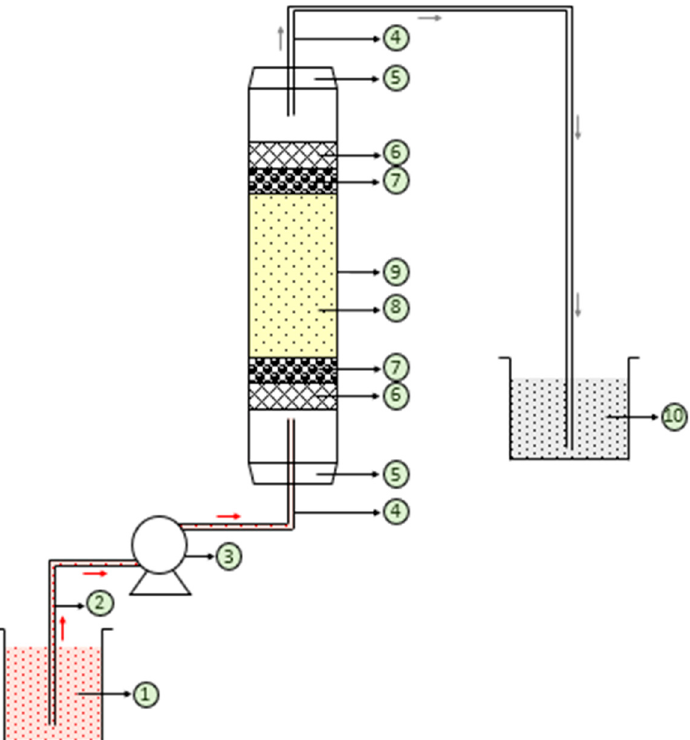
Figure 1. Schematic diagram of the fixed-bed adsorption column. ( 1 ) Influent CR dye solution; ( 2 ) silicon tube; ( 3 ) peristaltic pump; ( 4 ) glass tube; ( 5 ) rubber cork; ( 6 ) glass wool; ( 7 ) glass beads; ( 8 ) NNLP adsorbent; ( 9 ) glass column; ( 10 ) treated CR dye